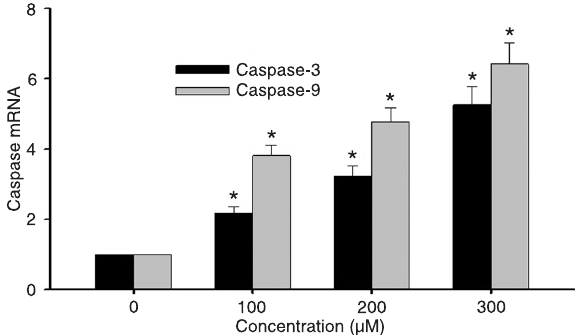
Figure 4. Rhein increased gene expression of caspase-9 and -3 in SGC-7901 cells in a dose-dependent manner. SGC-7901 cells were treated with rhein (0, 100, 200, or 300 µM) for 48 h. The expression of mRNAs was analyzed by real-time quantitative PCR and normalized by GAPDH expression. *P < 0.05 versus control group (0 µM) (two-way ANOVA followed by the Tukey post hoc test).